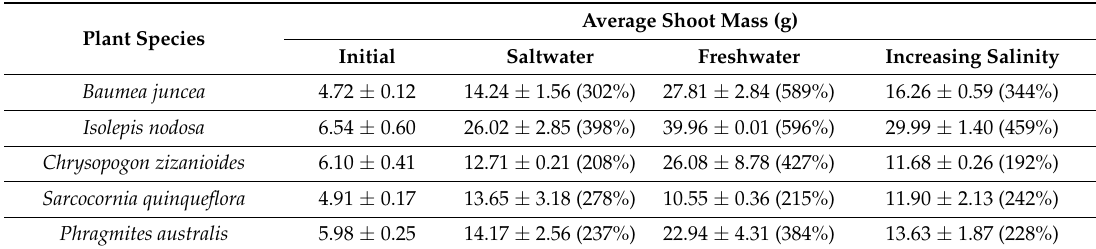
Table 1. Initial Tubestock Shoot Mass and Final Plant Shoot Mass for Each Species in Each Water Treatment (Percentage Change in Shoot Mass Shown in